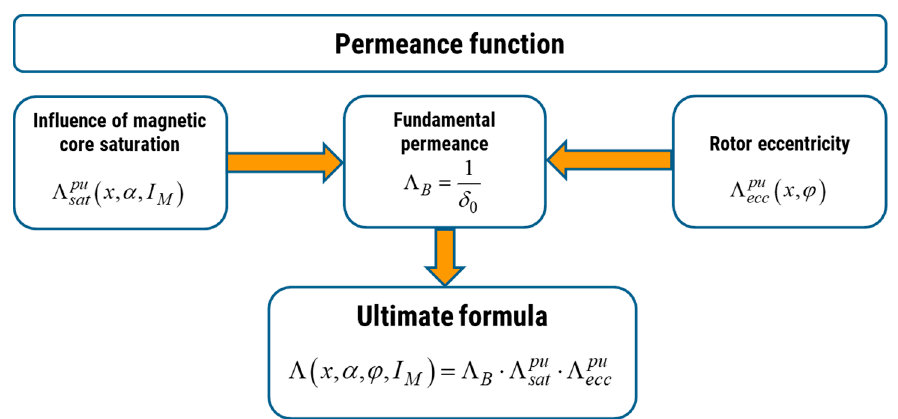
Figure 4. Illustration of the permeance function derivation method.